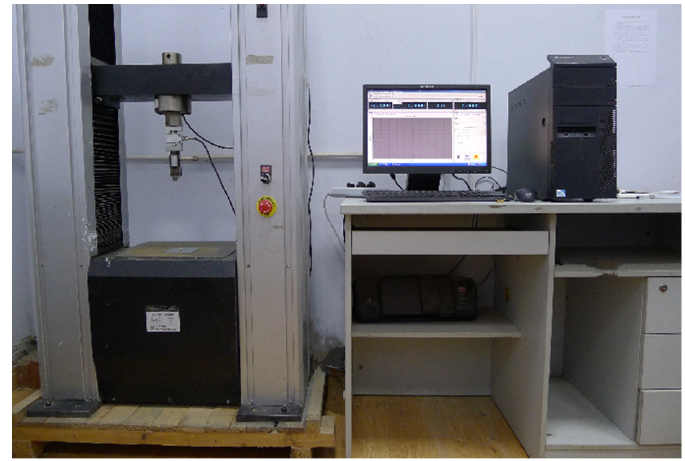
Figure 11. Machine used for the compression of soybean particle. The static coefficients of friction are measured by the inclined plane approach, see Figure 12. When the test begins, the free end of the inclined plate is lifted at a constant speed, the reading of the digital inclinometer is captured by a high-speed camera when the soybean particle starts to slide. The static coefficient of friction is then calculated as the tangent of the angle. The test is repeated five times for each variety of soybean